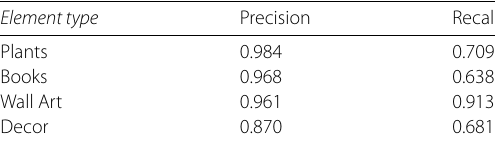
Table 1 Precision and recall for detecting the four decoration elements Elementtype Precision